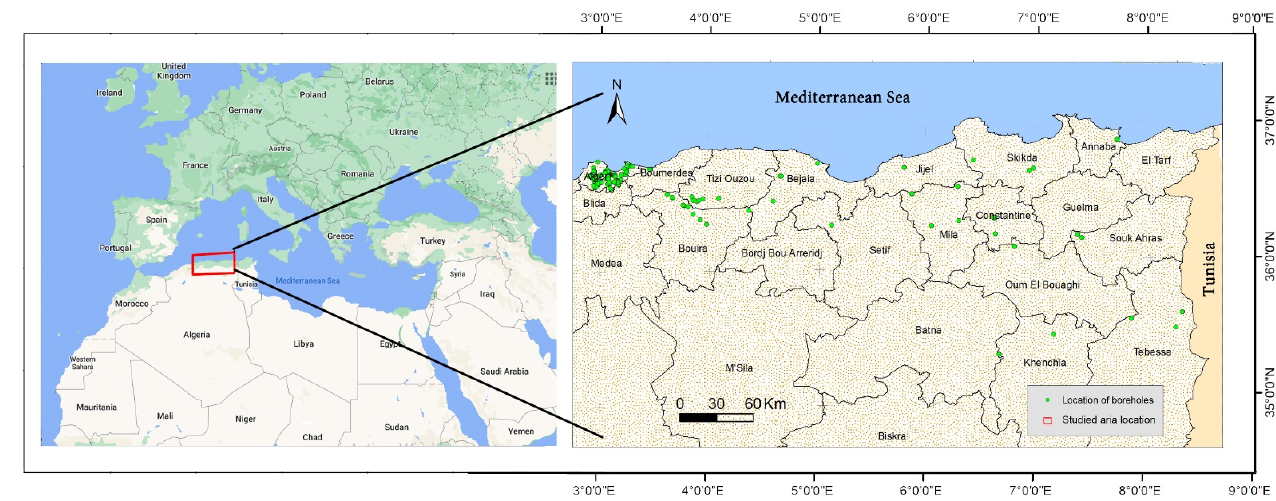
Figure 2. Map of the study area and collected boreholes sites.